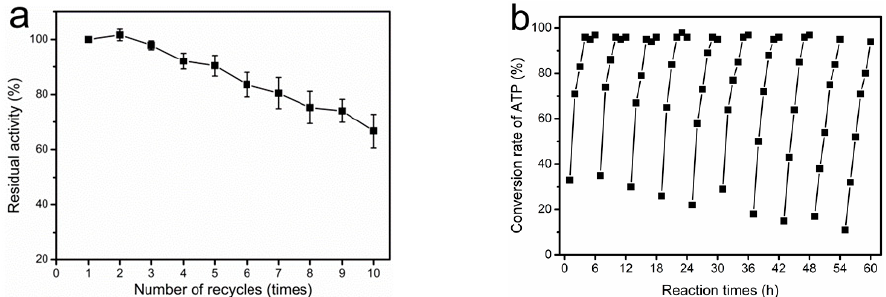
Figure 6. Reuse of magnetically immobilized cells for SAM biosynthesis. ( a ) The effect of recycling on the activity of magnetically immobilized cells. The residual activity was measured using the spectrophotometric assay. Enzyme activity was calculated according to the phosphate concentration that was released from the substrate ATP during the reaction; ( b ) Production of SAM with magnetically immobilized cells in 10 repeated batches. The reaction was performed in 100 mM Tris-HCl buffer containing 40 mM ATP, 50 mM L -methionine, 50 mM K 2 SO 4 , 100 mM MgSO 4 , and 0.3 M sodium p -toluenesulfonate, pH 7.0 with a 6-h incubation at 37 °C. The consumption of ATP and the production of SAM were determined by HPLC analysis, and the conversion rate of ATP was calculated.